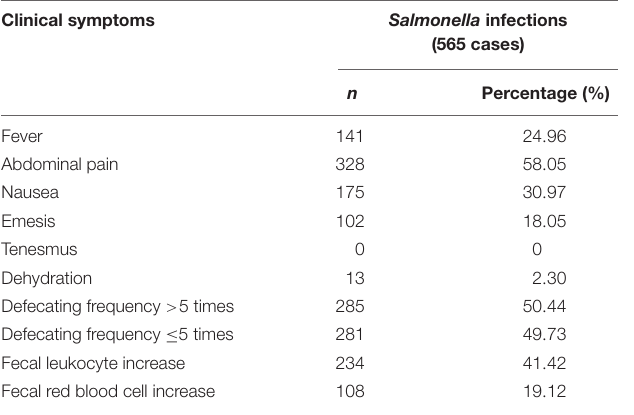
TABLE 1 | Clinical characteristics of Salmonella infections in the southwest of Shanghai in 1998 to 2017.